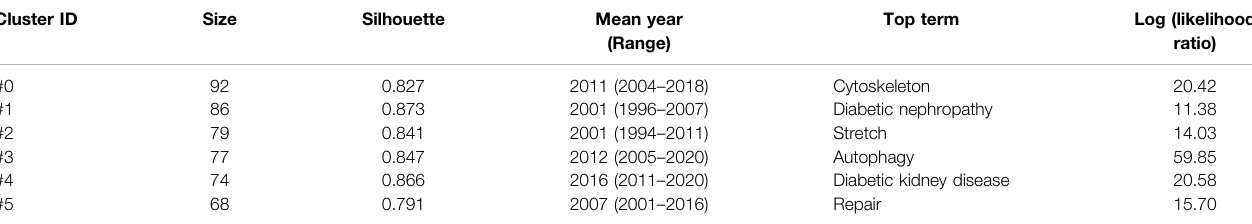
TABLE 6 | The top 6 clusters of co-cited references with the highest K value in podocyte injury